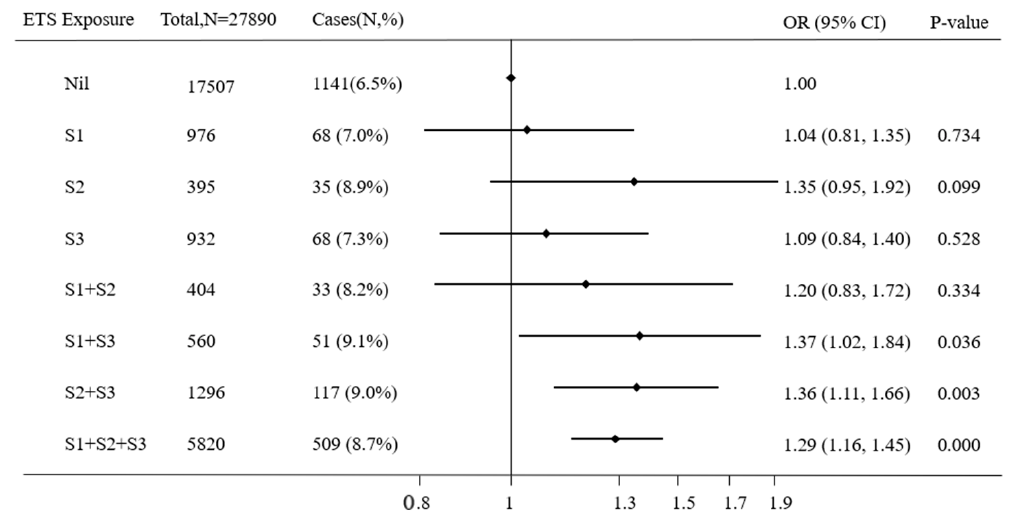
Figure 1. The associations of astigmatism with combinations of pre- and post-natal ETS exposure. ETS: Environmental tobacco smoke, OR: Odds ratios, S1: During pregnancy, S2: From birth to one year, S3: From one to three years. A binary logistic regression model was used, while adjusting for children’s gender and age, parental education level, family monthly income, parental age at childbirth, and electronic screen exposure.